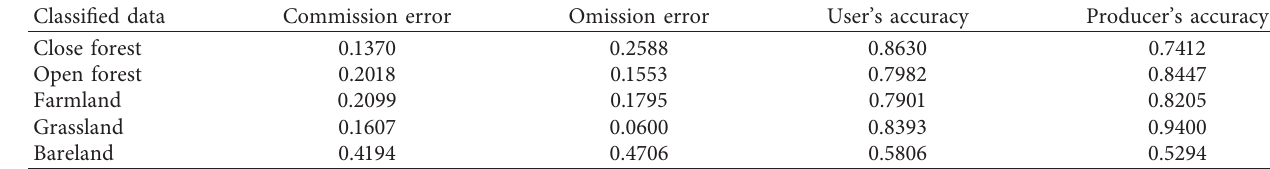
Table 6: Accuracy assessment statistical parameters for 2017 land use land cover (LULC) [32].